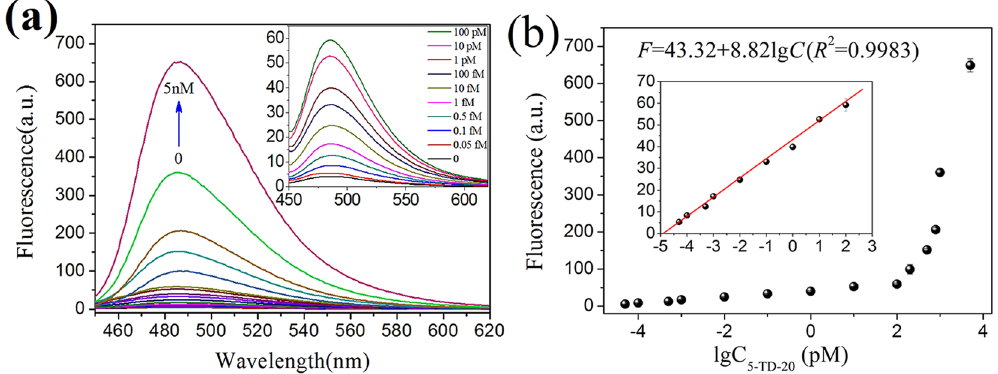
Figure 5. 5-TD-20 quantitation using ED-eRCA. ( a ) 5-TD-20 concentration-dependent fluorescent spectral change of the detection system; ( b ) 5-TD-20 concentration-dependent fluorescent signal change at 485 nm. The insert in ( a ) shows the fluorescence spectral change in the 5-TD-20 concentration range of 0–100 pM; The insert in ( b ) shows the fluorescence signal change at 485 nm in the 5-TD-20 concentration range of 0.05 fM–100 pM. The solid line represents a linear fit to the data. All experiments were performed in